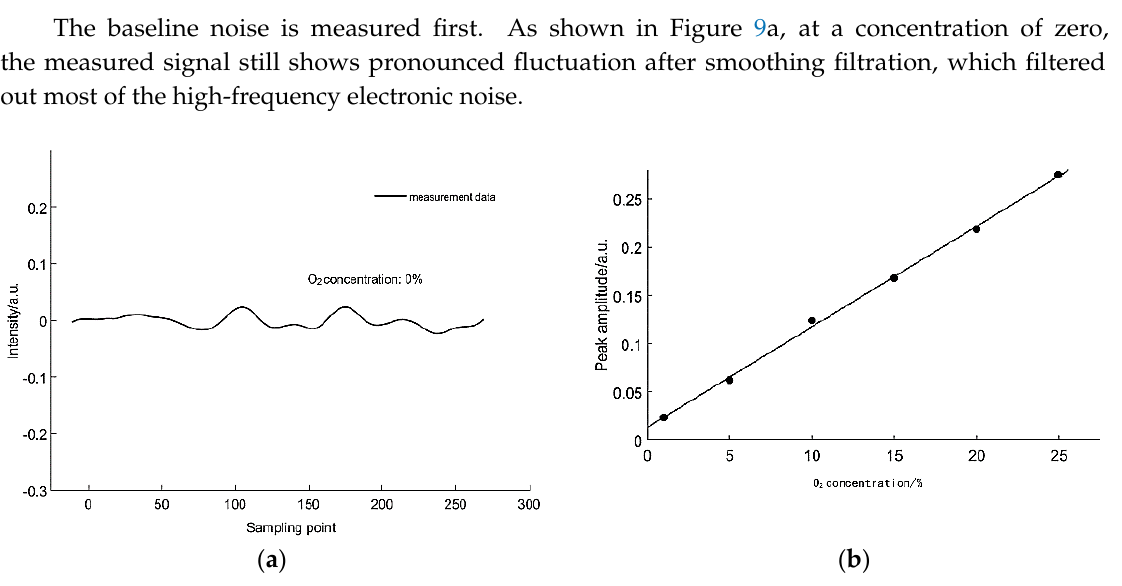
Figure 9. ( a ) Zero concentration fringe. ( b ) Relationship between the peak amplitude and gas concentration. This figure was adapted from [47].